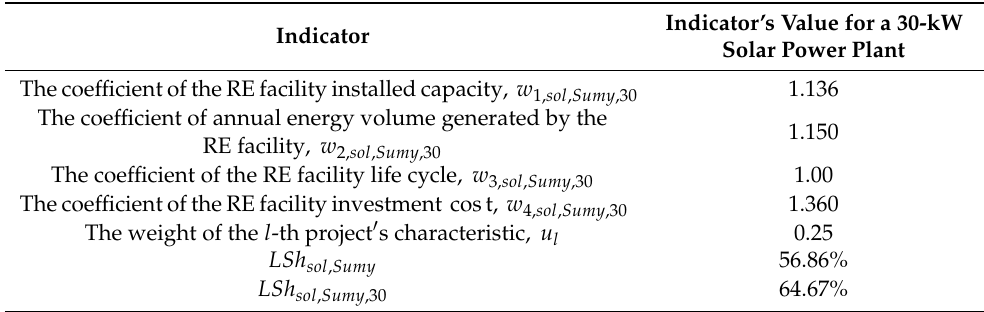
Table 9. Calculation of the coefficients w l , i , j , n and LSh i , j , n for the project of constructing a home 30-kW solar photovoltaic power plant located in the Sumy region, Ukraine (calculated by the